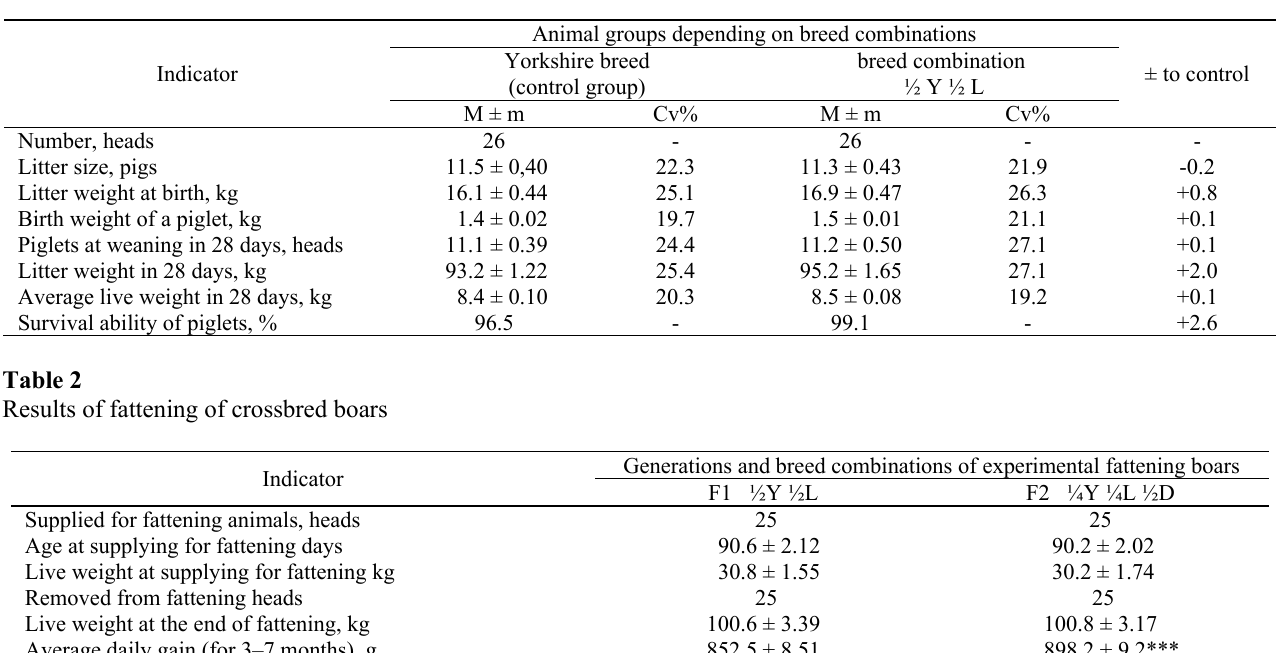
Reproductive qualities of purebred and crossbred sows of the second farrowing Indicator